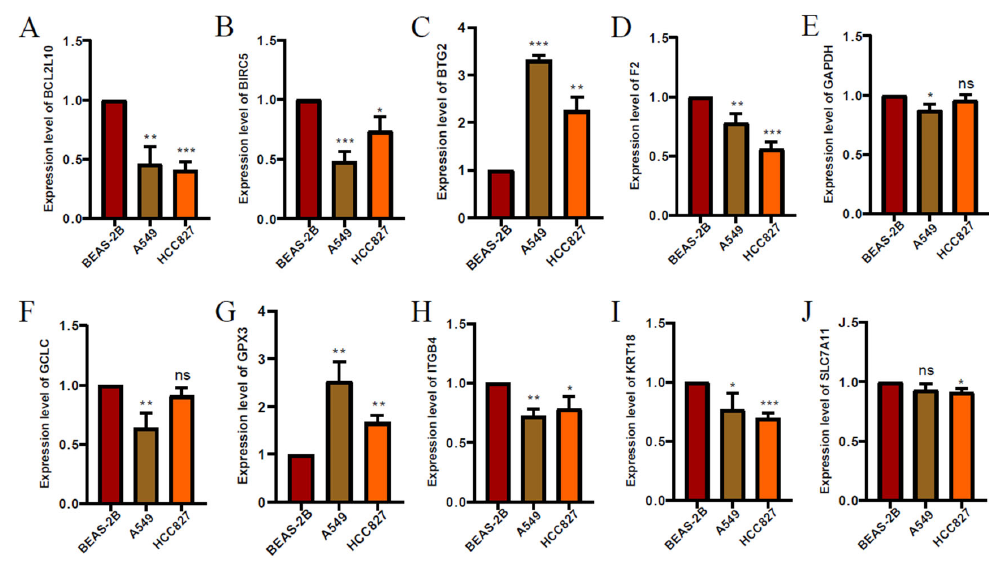
Figure 9. The expression levels of each gene from prognostic model. ( A ) (BCL2L10), ( B ) (BIRC5), ( C ) (BTG2), ( D ) (F2), ( E ) (GAPDH), ( F ) (GCLC), ( G ) (GPX3), ( H ) (ITGB4), ( I ) (KRT18), ( J ) (SLC7A11) in lung adenocarcinoma cell lines detected by RT-qPCR. ∗ p < 0.05, ∗∗ p < 0.01, ∗∗∗ p < 0.001.